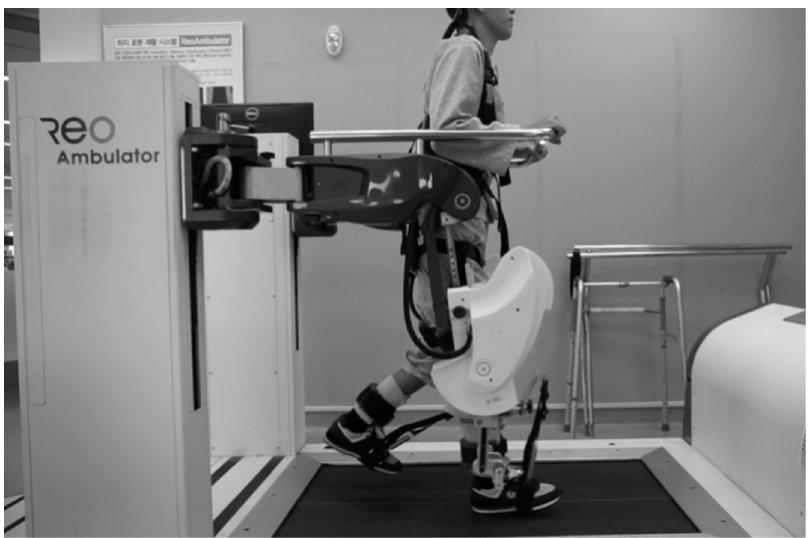
Figure 1. Robot assisted gait.